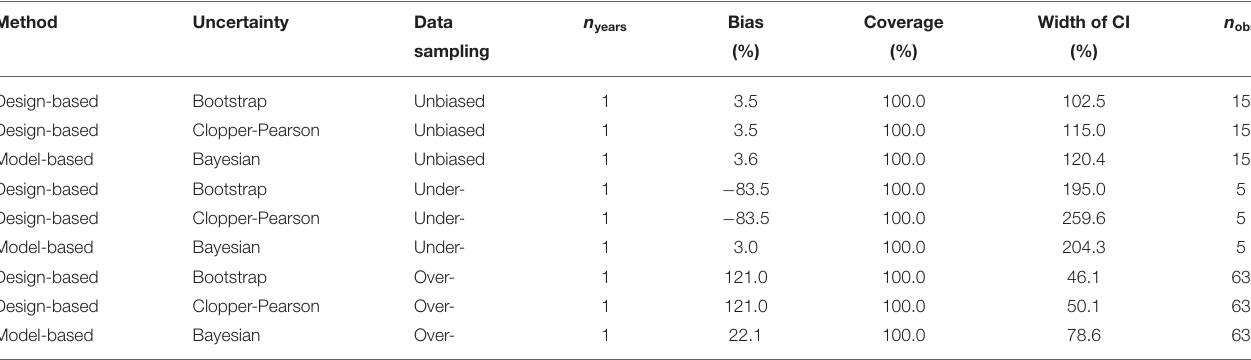
TABLE 1 | Statistical properties of estimates from the design- and model-based